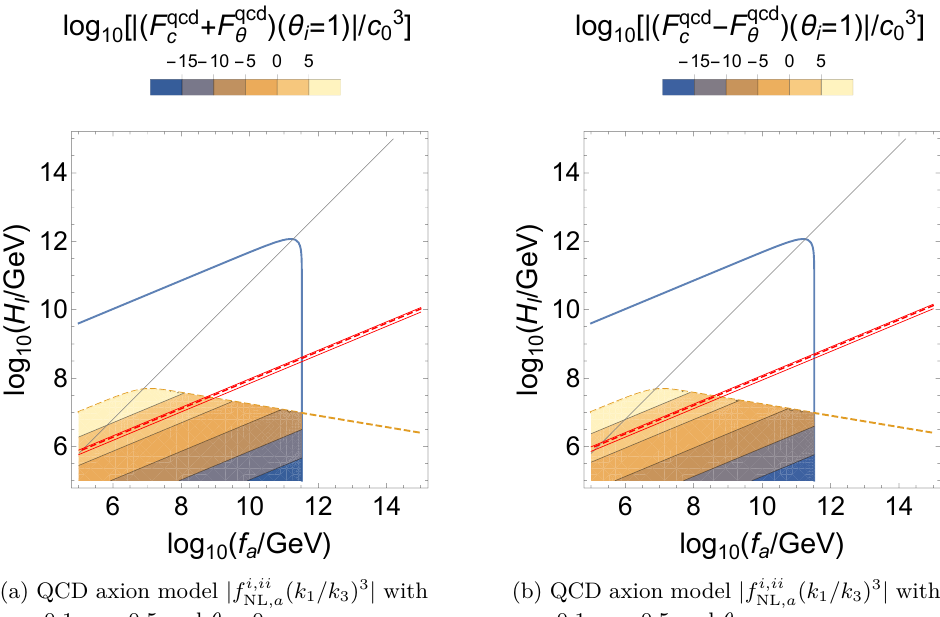
Figure 9. In QCD axion model, the amplitude of axion isocurvature non-Gaussianity ( k ) 3 | = | F cos 2 θ + F with µ = 0 . 1 , c = 0 . 5 and θ = 1 . The red lines show the | f i,ii 1 /k 3 θ c | i NL ,a local shape constriant from Planck 2018 T+E constraint f i,ii = − 290 ± 210 , if c is taken to be 0 NL